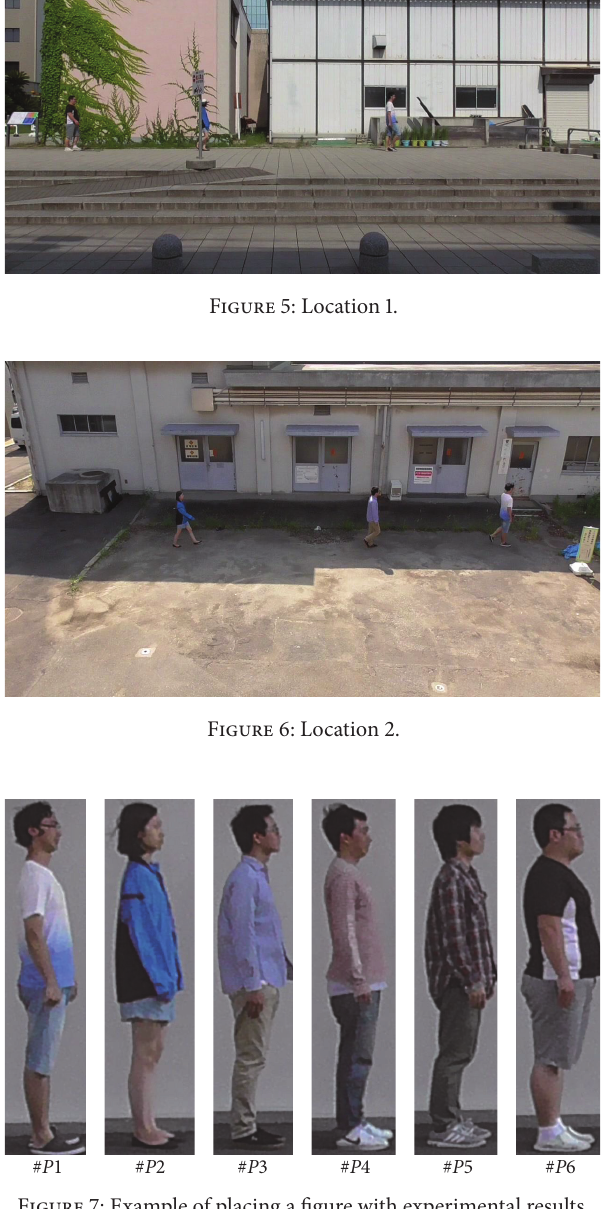
Figure 7: Example of placing a figure with experimental results.